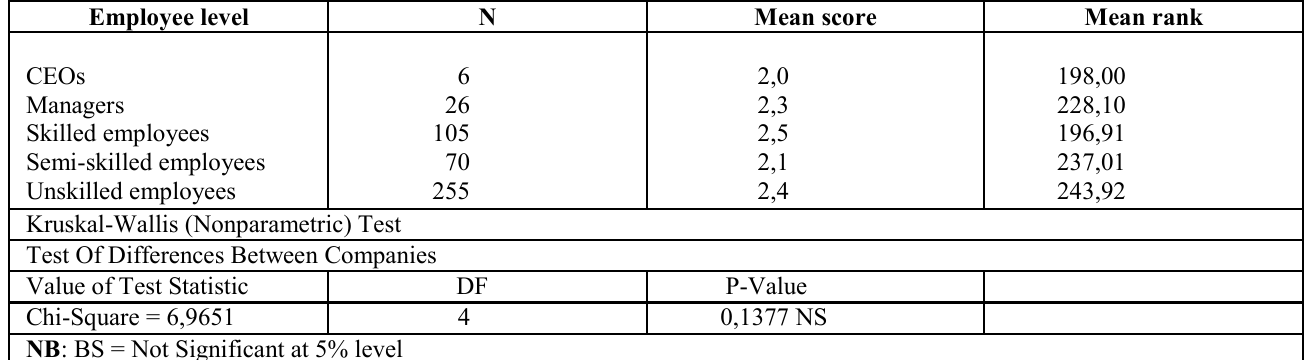
Table 5: Employee Level Means: Customer Oriented Vs Accounting Oriented Employee